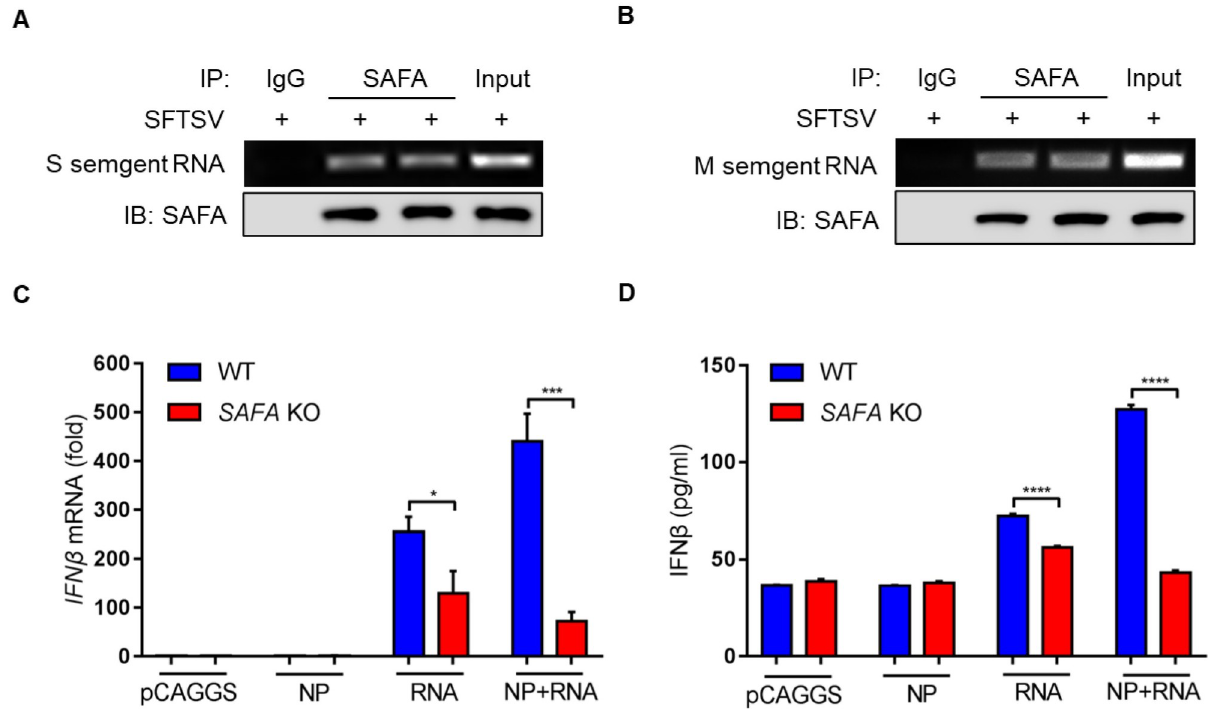
Fig 7. SAFA is involved in detecting SFTSV NP and RNA in the cytoplasm. (A-B) MEF cells were infected with or without SFTSV (MOI = 10) for 24 h, interaction between the S (A) or M (B) segment of SFTSV RNA and SAFA was detected by RIP. (C-D) MEF cells were transfected with Flag-tagged SFTSV NP for 24 h, and the purified SFTSV RNA for 6 h or both, IFN β mRNA level was assessed by RT-PCR (C) , IFN β cytokine levels were analyzed by ELISA (D) . Data were obtained from three independent experiments (n = 3). � P < 0.05, ��� P < 0.0001, ���� P <